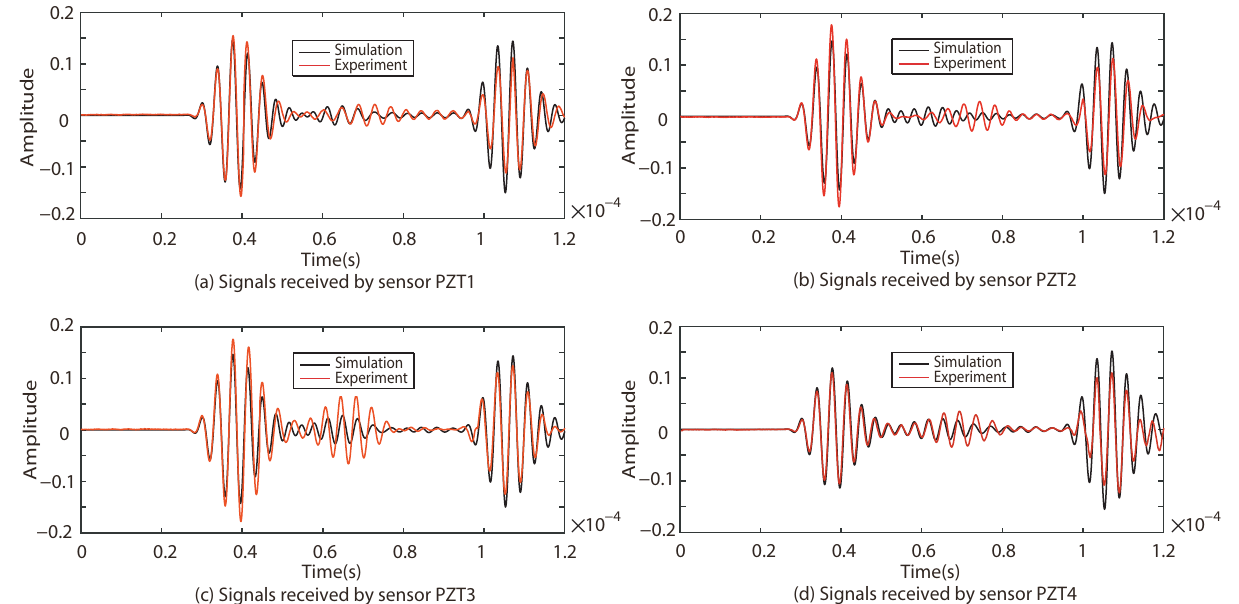
Figure 17. Comparison of experimental and simulation results under the center frequency of 250 kHz.